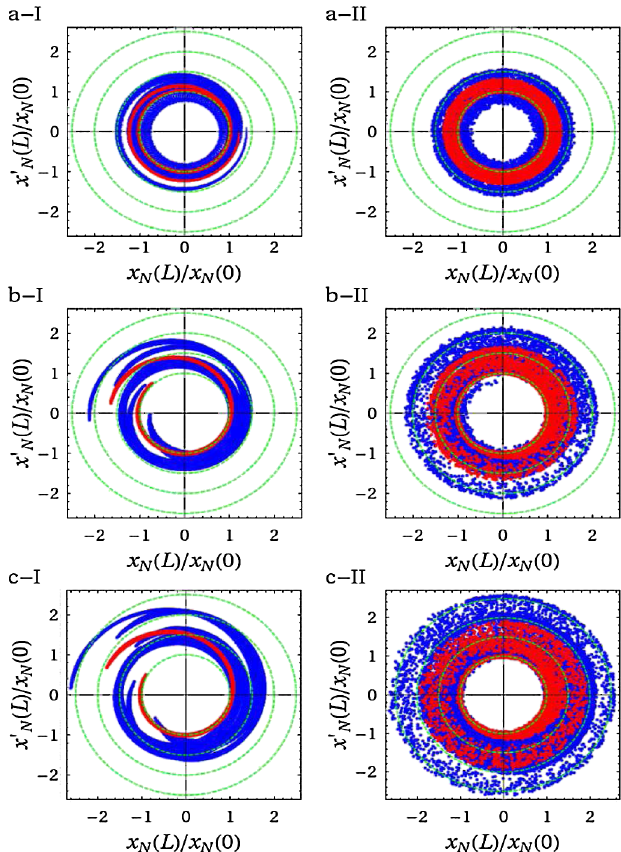
FIG. 7. The normalized final offset of the bunches with con- stant charge at the end of the DBL1 (I, left-hand side) and DBL2 (II, right-hand side) for an offset incoming train, (a) FODO, (b) doublet, and (c) triplet. Each bunch divided into 51 slices, each slice consists of 101 macroparticles and each dot represents a single macroparticle. The group of red dots shows first bunch and blue dots show trailing